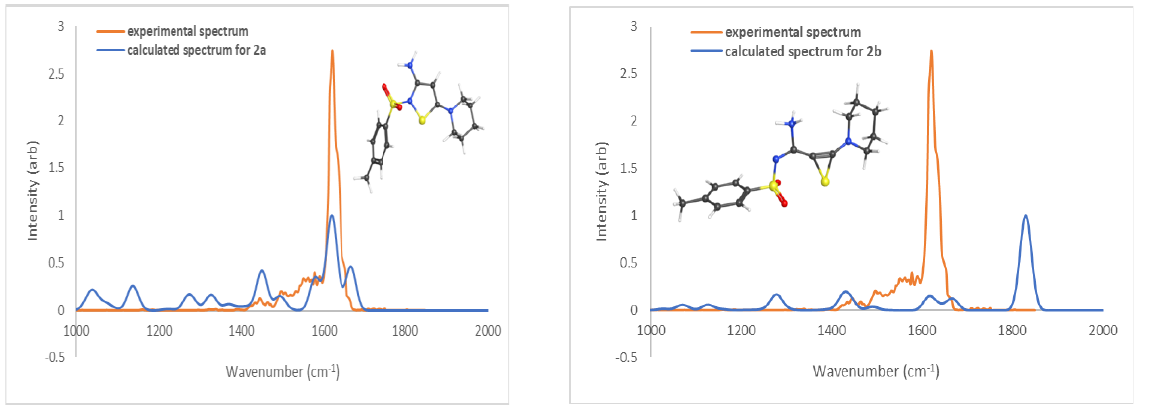
Figure 3. Calculated (blue trace) IR spectra (B3LYP/6-311+g(d,p)) for 2a (0.0 kJ/mol) and 2b (259.1 kJ/mol) vs. experimental (orange trace) IRMPD spectrum of the ion m / z 338. Similar to the 2a/2b ions, two potential structures were considered for the m / z 298 ion, 3a and 3b . In this case, the isothiazole structure ( 3a ) was also found to be substantially lower in energy, by 264 kJ/mol. This energy difference is close to that determined for the two isomers considered for m / z 338, as m / z 298 differs only by the dimethylamine group rather than the piperidinyl moiety. IRMPD ion-spectroscopy findings are also similar and in agreement with theoretical calculations. As shown in Figure 4, there is an acceptable match between the experimental IRMPD spectrum (orange trace) and the theoretical IR spectrum of 3a (blue trace). The most prominent strong absorption band at 1640 cm -1 in the experimental trace matches the absorption location of the two strong bands in the calculated spectrum, the C-N (between C15 and N22) stretch coupled with C-C stretches in the thiazole ring at 1620 cm − 1 and NH 2 scissoring mode at 1664 cm − 1 . The higher-energy isomeric structure 3b can again be rejected because of the absence in the experimental spectrum of the strong absorption band at 1833 cm − 1 that is calculated for the C=C stretch of the thiirene ring (blue trace).